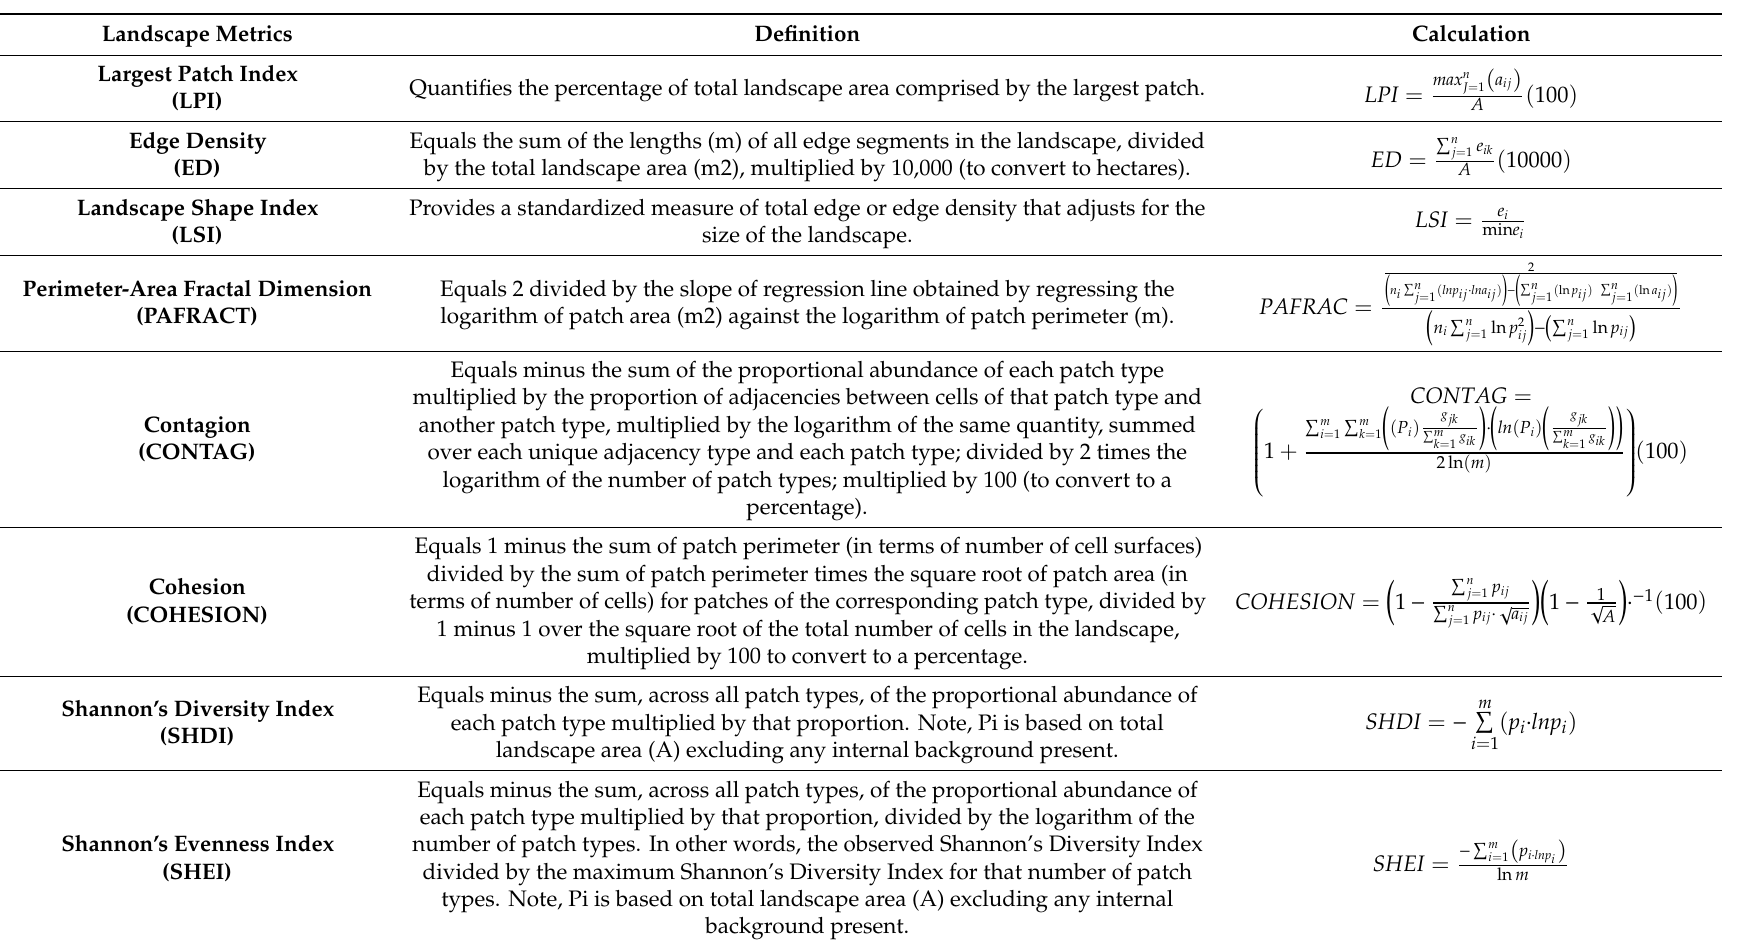
Table A1. Description of landscape